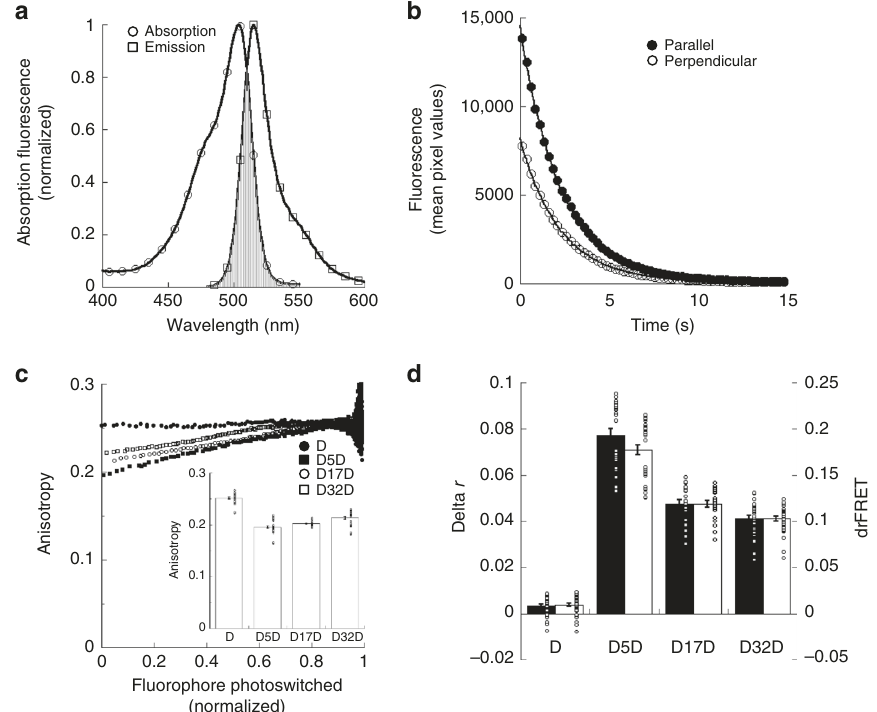
Fig. 2 psAFRET measurements of Dronpa fl uorescent protein dimers. a Absorption (open circles) and emission (open squares) spectra of puri fi ed Dronpa protein are shown in the on state. The spectral overlap between the absorption and emission are shown by the gray area. b A cell expressing Dronpa was excited using 488 nm excitation and imaged with parallel and perpendicular emission channels. The fl uorescence intensities in the parallel (black circles) and perpendicular (white circles) channels are displayed as Dronpa is photoswitched off. c COS-7 cells expressing Dronpa (black circles), D5D (black squares), D17D (white circles), or D32D (white squares) were imaged and photoswitched. The anisotropy was determined and displayed as a function of the fl uorophore photoswitched (inset). The conventional steady-state anisotropy for each chimera was determined from the fi rst data points of the photoswitching experiment. ANOVA indicated signi fi cant differences for all chimeras ( p -value < 0.05). Cohen ’ s d values ranged 0.56 – 4.52. Data represent mean ± sem ( n = 30, 33, 23, and 33 for D, D5D, D17D, and D32D, respectively). d The data points representing ~80% of the fl uorescence were fi tted to linear equations for experiments performed and analyzed as shown in ( c ). These were used to determine the anisotropy before and after photoswitching. The difference in anisotropy (delta r, black columns) is shown compared with its conversion to drFRET ef fi ciency (white columns) using Eq. (2). Signi fi cant delta r differences were found for all chimeras ( p -value < 0.05). Cohen ’ s d values ranged 0.67 – 7.66. Signi fi cant drFRET differences were found for all chimeras ( p -value < 0.05). Cohen ’ s d values ranged 0.79 – 8.23. Data represent mean ± sem ( n = 30, 33, 23, and 33 for D, D5D, D17D, and D32D, respectively). Circles overlaid on columns in the bar graphs represent individual data points. Source data are provided as a Source Data fi